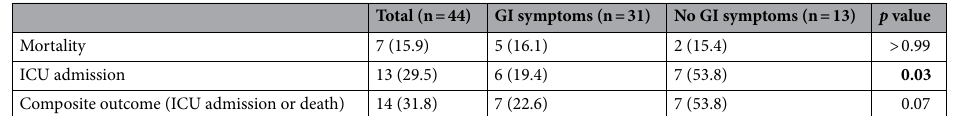
Table 2. Patient outcomes in patients with and without GI symptoms. The bold values indicate p -value < 0.05. The absolute number and percentage of the cohort (in parentheses) with each indicated outcome. Statistical comparisons are by Fisher’s exact